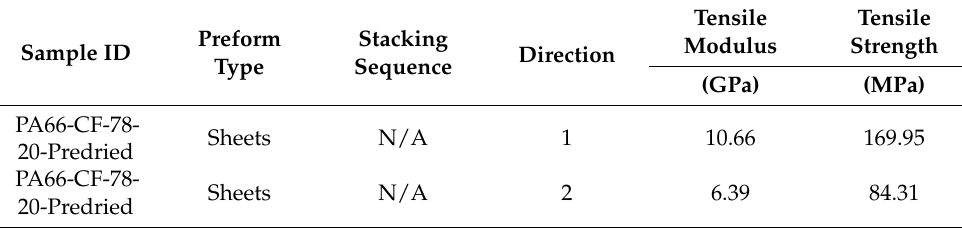
Table 7. Tensile modulus and strength of PA66-CF (preform ‘Sheet’).